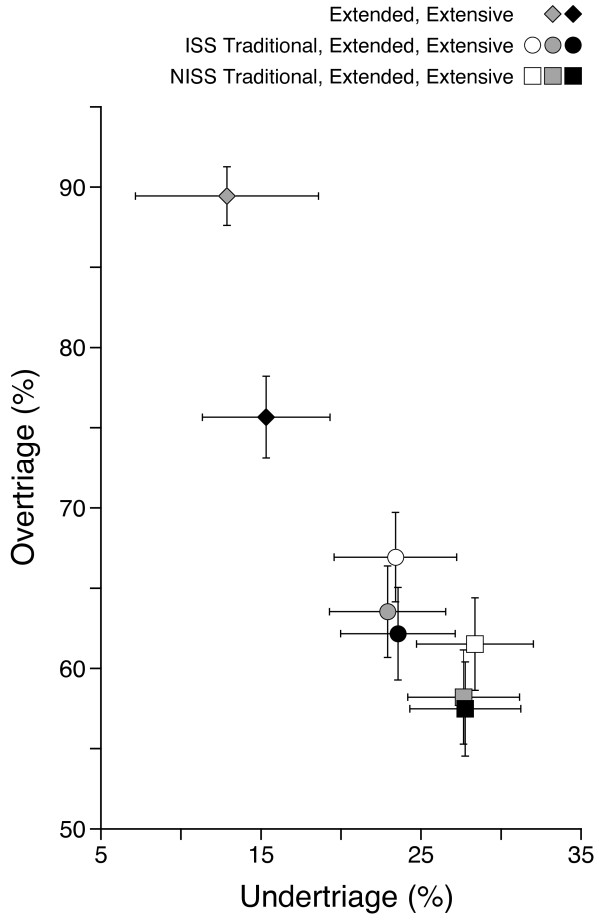
Consequences of the various definitions of major trauma for perceived over- and undertriage. ISS-based definitions are shown as circles, NISS-based definitions are shown as squares, and diamonds represent definitions that are not based on anatomic criteria (cf. Tables 3 and 4). The symbols representing “extended” and “extensive” definitions are grey and black, respectively. The lines denote 95% confidence intervals.